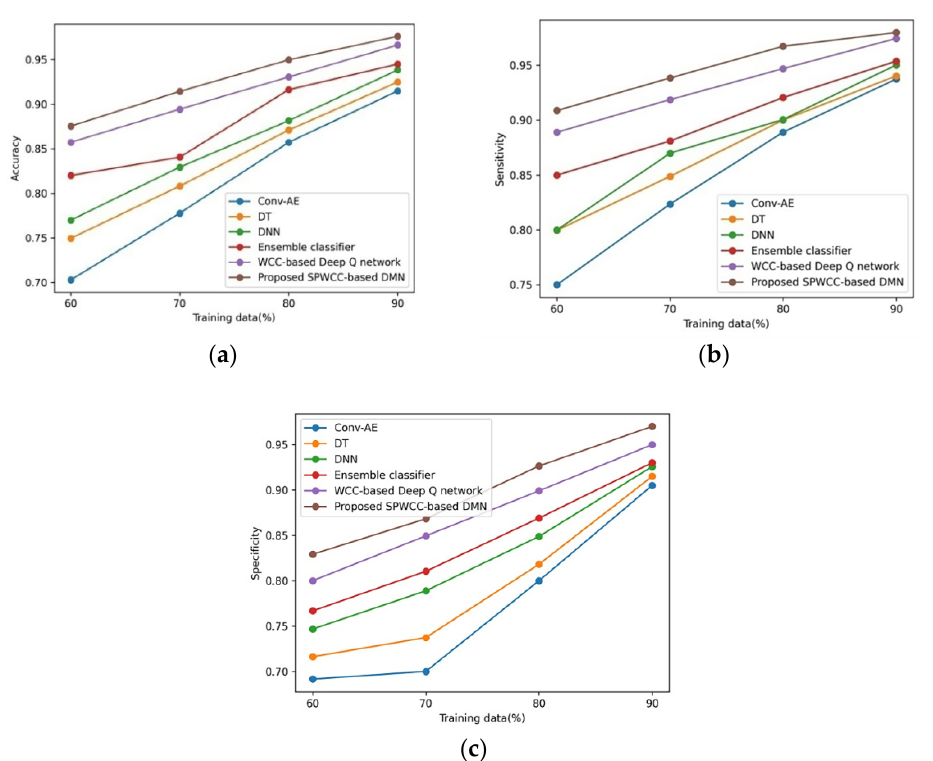
Figure 4. Assessment of techniques without attack considering ( a ) accuracy, ( b ) sensitivity, and ( c ) specificity.